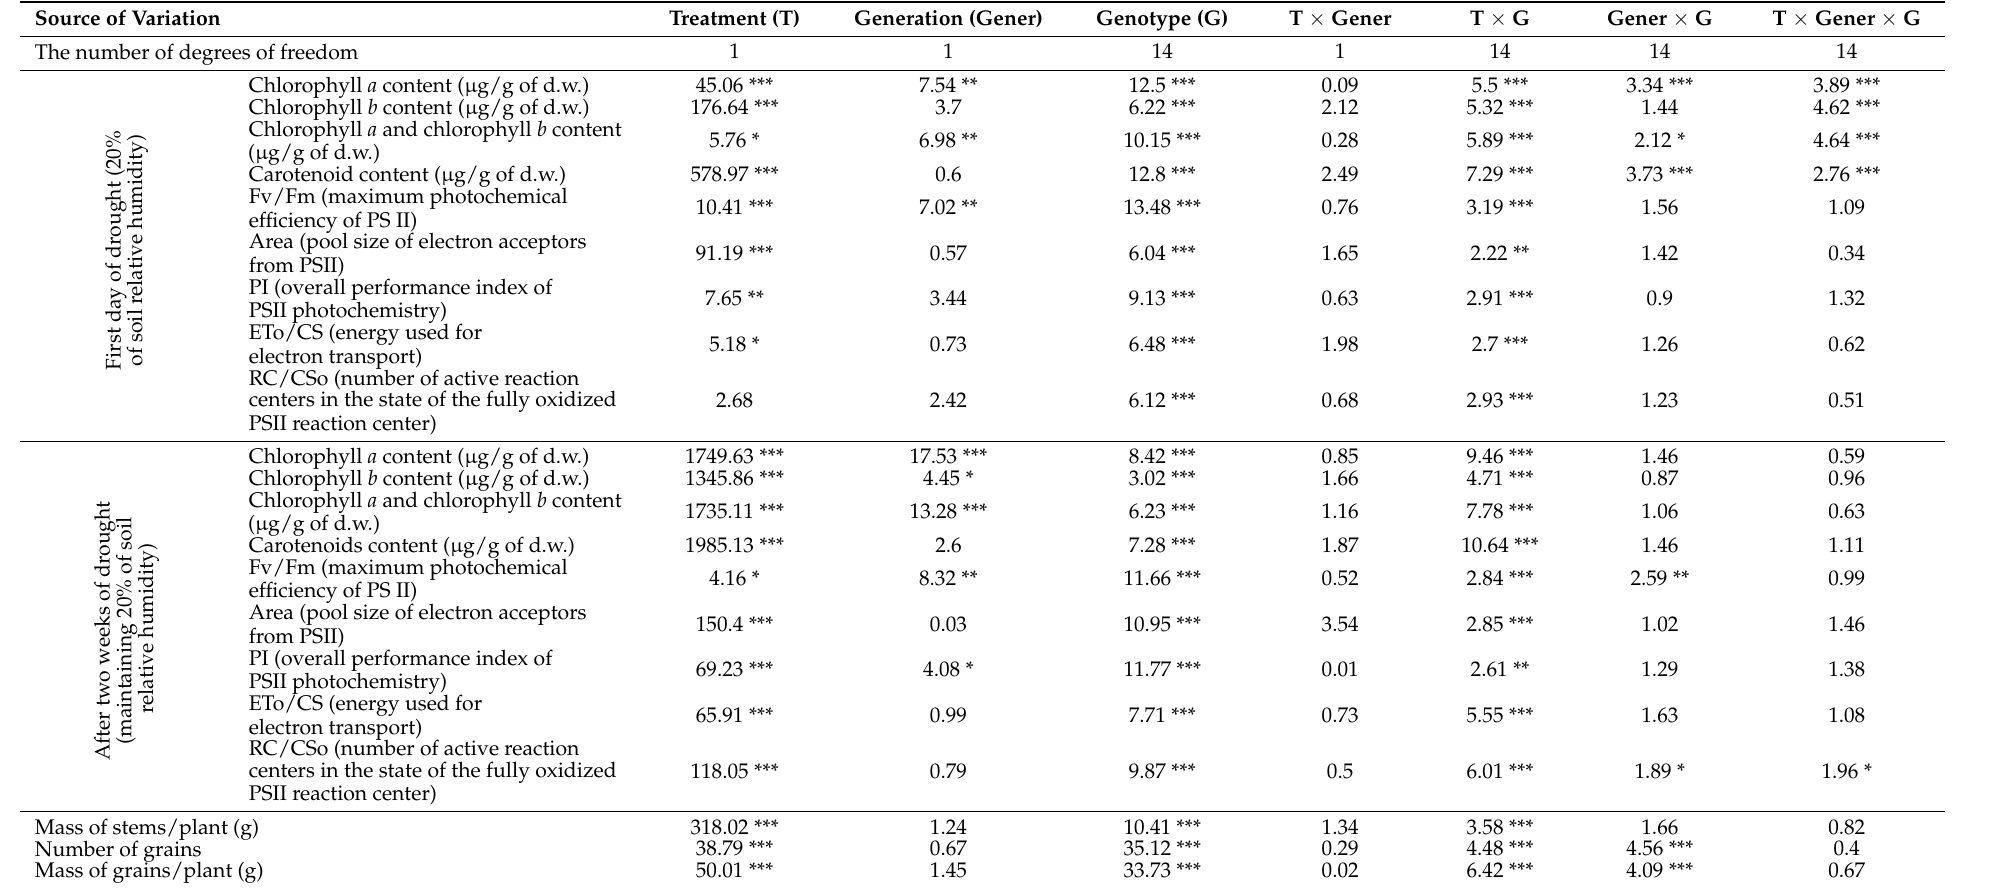
Table 1. F -statistics from three-way analysis of variance for 21 observed traits (t1–t21, respectively). Source of